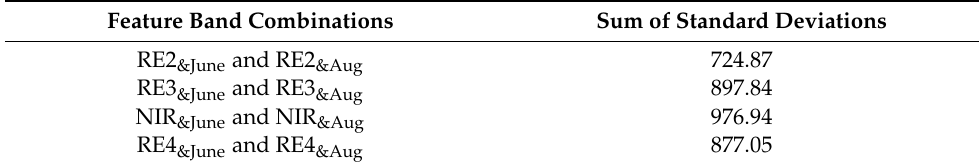
Table 3. Sum of standard deviations of feature band combinations for scrub